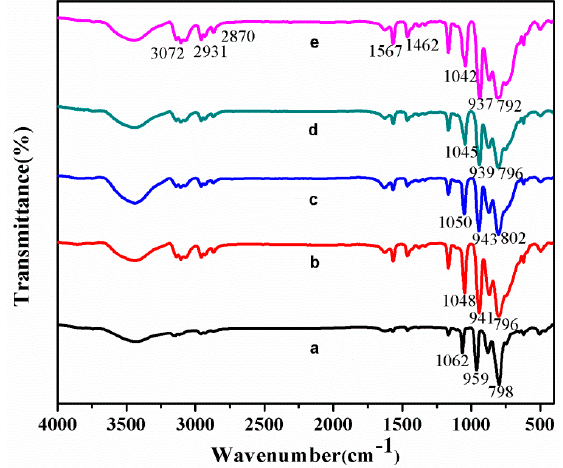
Figure 1. FT ‐ IR spectra of hybrid materials: ( a ) [Bmim] 3 PMo 12 O 40 , ( b ) [Bmim] 5 PMo 11 Co(H 2 O)O 39 , ( c ) [Bmim] 5 PMo 11 Ni(H 2 O)O 39 , ( d ) [Bmim] 5 PMo 11 Zn(H 2 O)O 39 , ( e ) [Bmim] 5 PMo 11 Mn(H 2 O)O 39 .